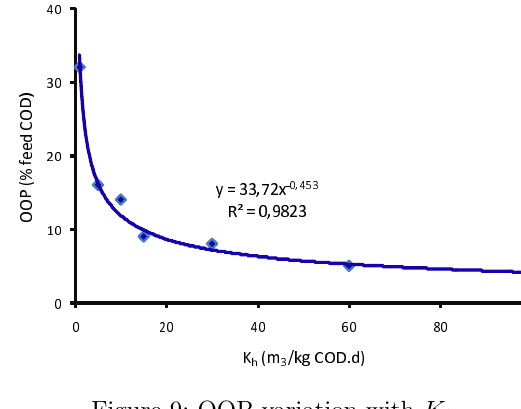
Figure 9: OOP variation with K h .